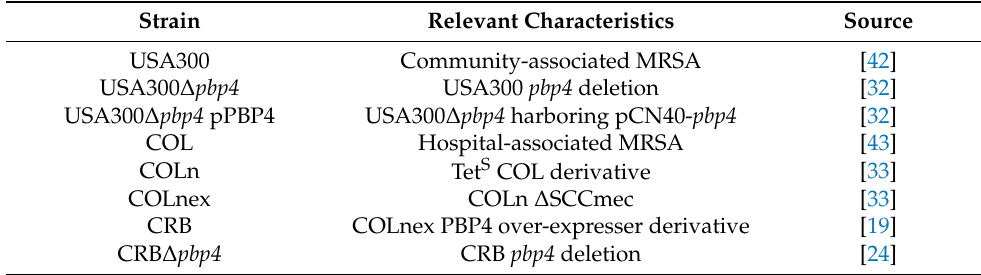
Table 3. Bacterial Strains and